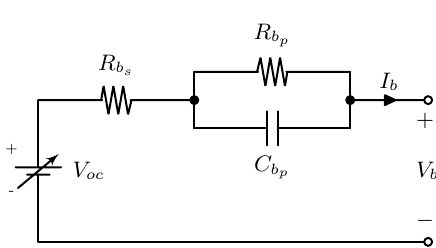
Figure 4. Thévenin model of a battery with a single branch.